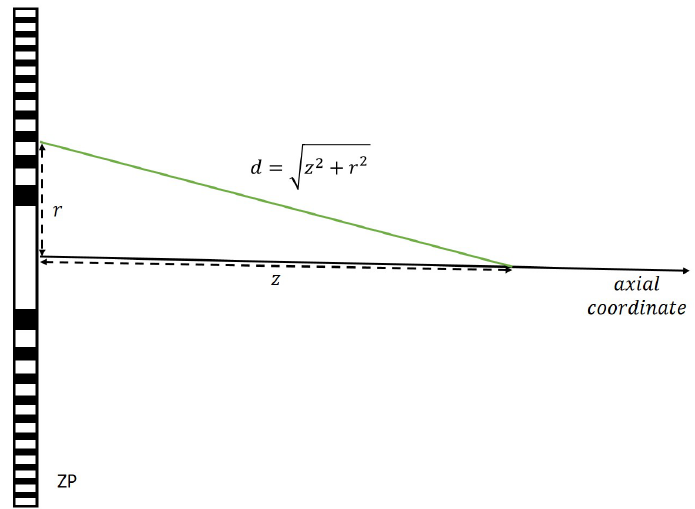
Figure 1. Schematic of the zone plate focusing